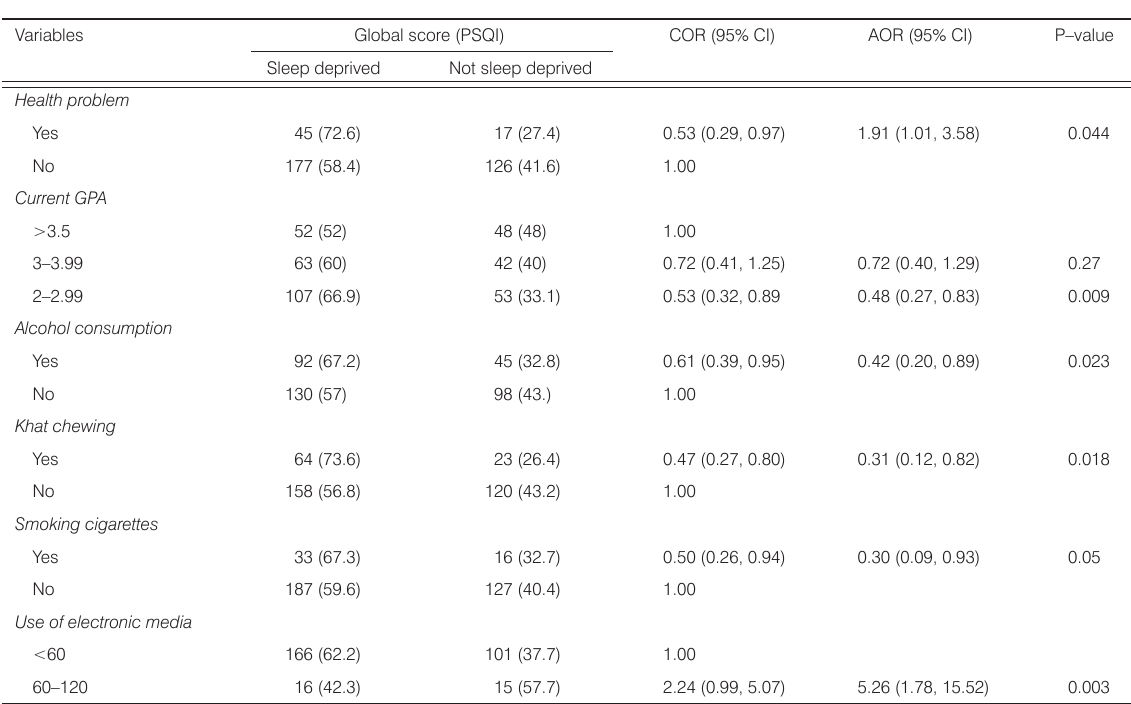
Table 3. Factors affecting sleep quality among students of the Institute of Health, Jimma University, 2019 ( N = 365).